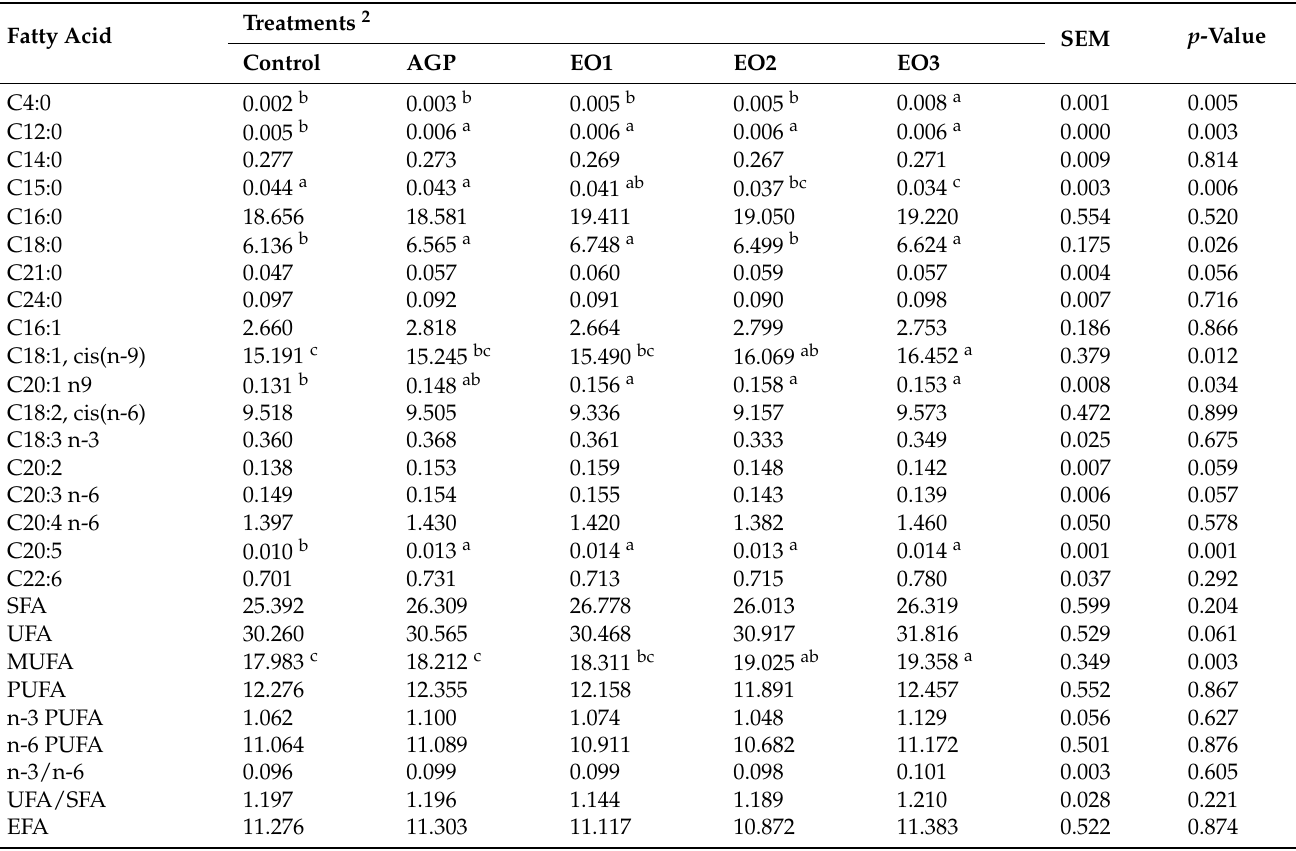
Table 4. Effects of dietary supplementation with oregano essential oil on fatty acid composition of egg yolk. (g/100 g) 1 .